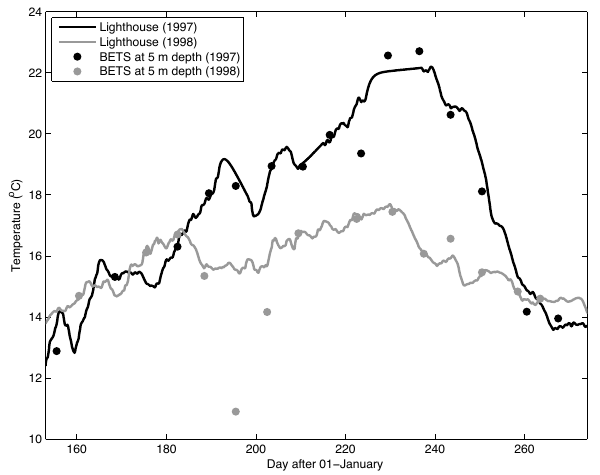
Figure 10. Near-surface temperature time series (1 June to 30 September) from Kiel lighthouse for a selected year with high (1998) and with low frequent upwelling (1997) wind conditions. Dots indicate the respective BE temperature record (15 surveys in 1998, 14 surveys in